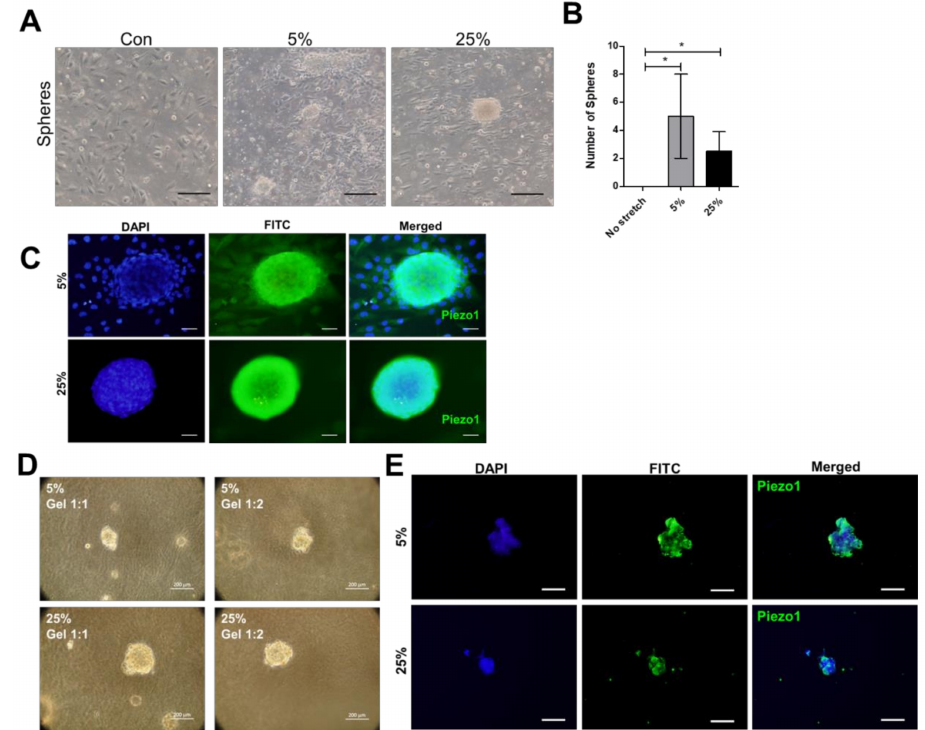
Figure 6. Cyclic stretch enhances growth of clustered cells expressing Piezo1 that survive in 3D hydrogel. ( A , B ) The 24 h stretching formed clustered cells with spherical appearance. Scale bar = 100 µ m. ( C ) Immunofluorescence assay detected Piezo1 in the clustered cardiomyocytes. Scale bar = 20 µ m. ( D ) The clustered cardiomyocytes were transferred to hydrogel, cultured for 7 days with cover medium changed every 2 days. Scale bar = 200 µ m. ( E ) After 7 days, the cells in hydrogel were embedded in paraffin, analyzed for Piezo1 expression by immunohistochemistry. Scale bar = 200 µ m. Data represent at least three independent experiments in SEM ± SD. *, p value <